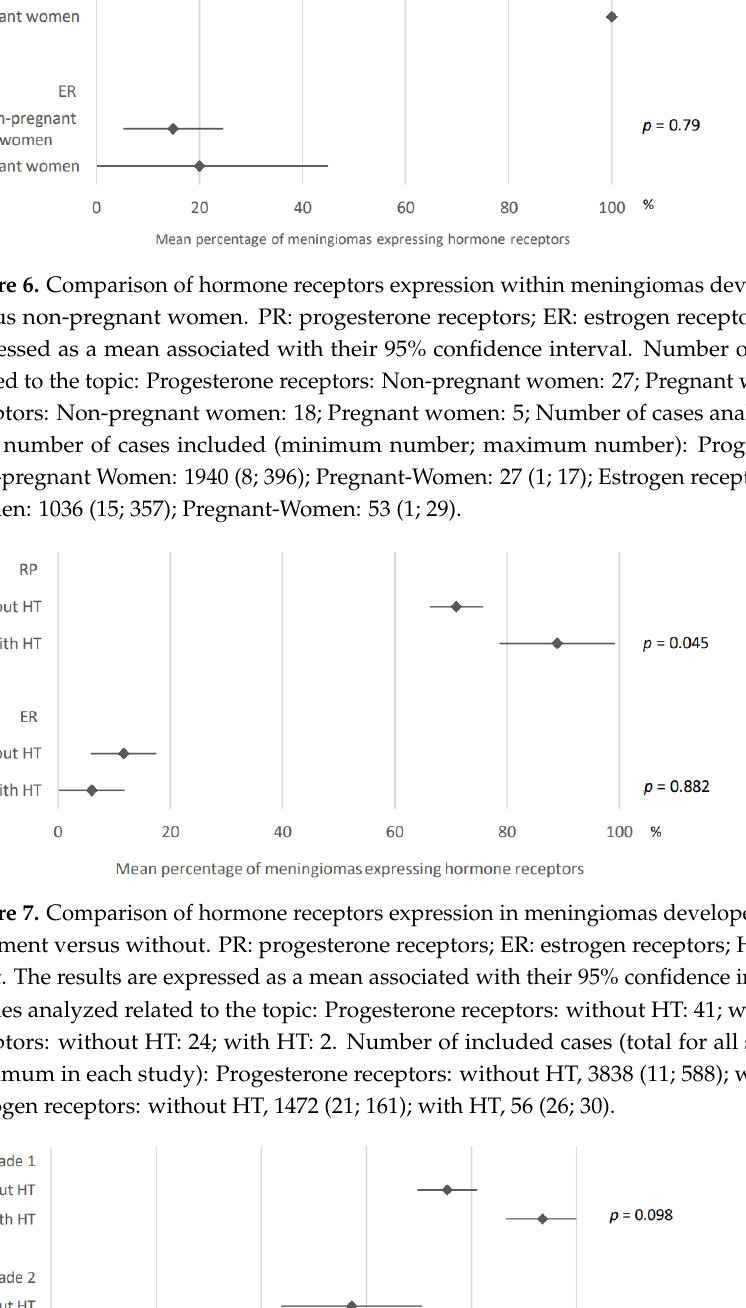
Figure 6. Comparison of hormone receptors expression within meningiomas developed in pregnant versus non-pregnant women. PR: progesterone receptors; ER: estrogen receptors. The results are